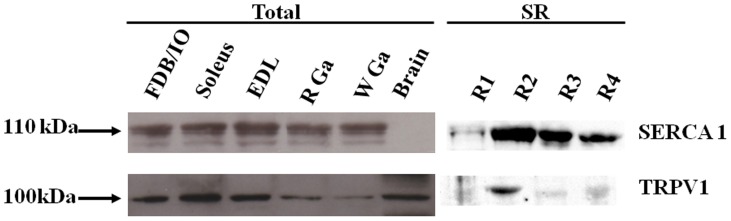
Expression of TRPV1 and SERCA1 in skeletal muscle.Left panel: Western blot analysis of total protein extracts (25 µg) with anti-SERCA1 (top panel) and anti-TRPV1 antibodies (low panel) from the following tissues: flexus digitorum brevis/interosseal (FDB/IO), soleus, extensor digitorum longus (EDL), red and white gastrocnemius (R Ga and W Ga) and brain. Right panel: Localization of TRPV1 in sarcotubular membrane fractions (R1, fraction enriched in light SR; R2, fraction enriched in longitudinal SR; R3, fraction containing a mixture of longitudinal SR and terminal cisternae; R4, fraction enriched in terminal cisternae): 30 µg of protein from each fraction was separated on SDS/PAGE.